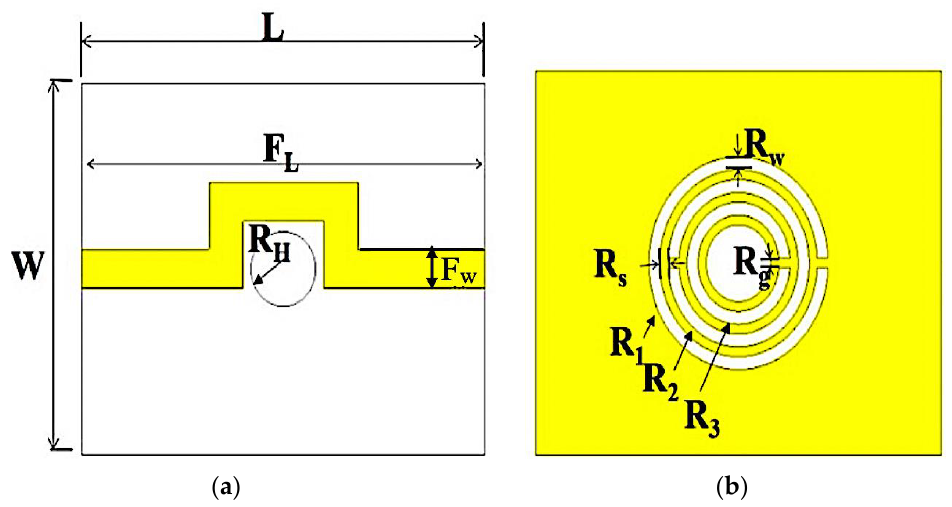
Figure 2. Curve-feed sensor design structure; ( a ) Top view of the transmission line position; ( b ) Bottom view of the defected ground structure of a TR curve-feed CSRR.